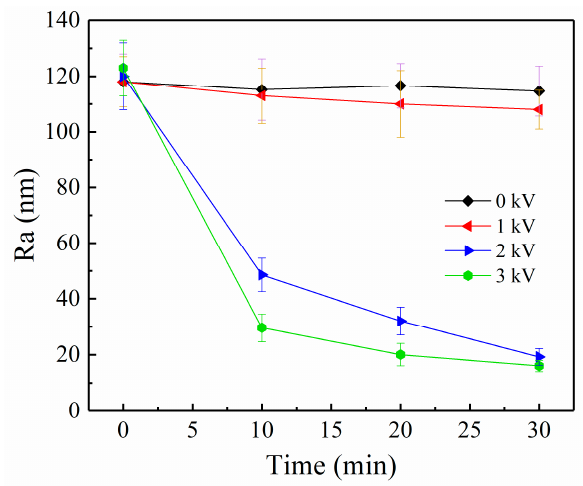
Figure 11. The roughness brass workpiece surface as a function polishing time at different working voltages (rotation speed = 200 r/min, machining gap = 0.2 mm).